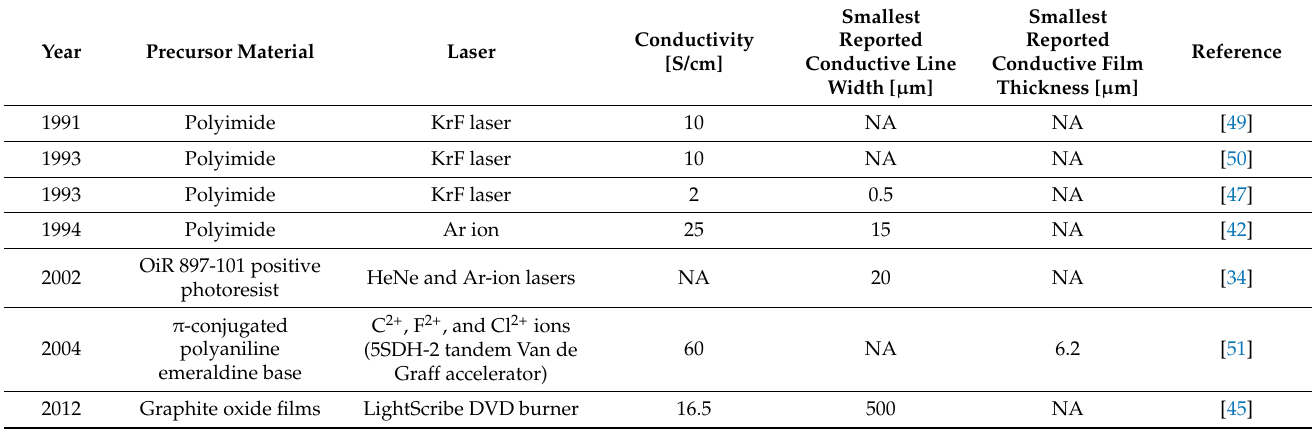
Table 1. Table of reported conductivities and resolutions achiesved through LLP using various laser typses on various substrates.